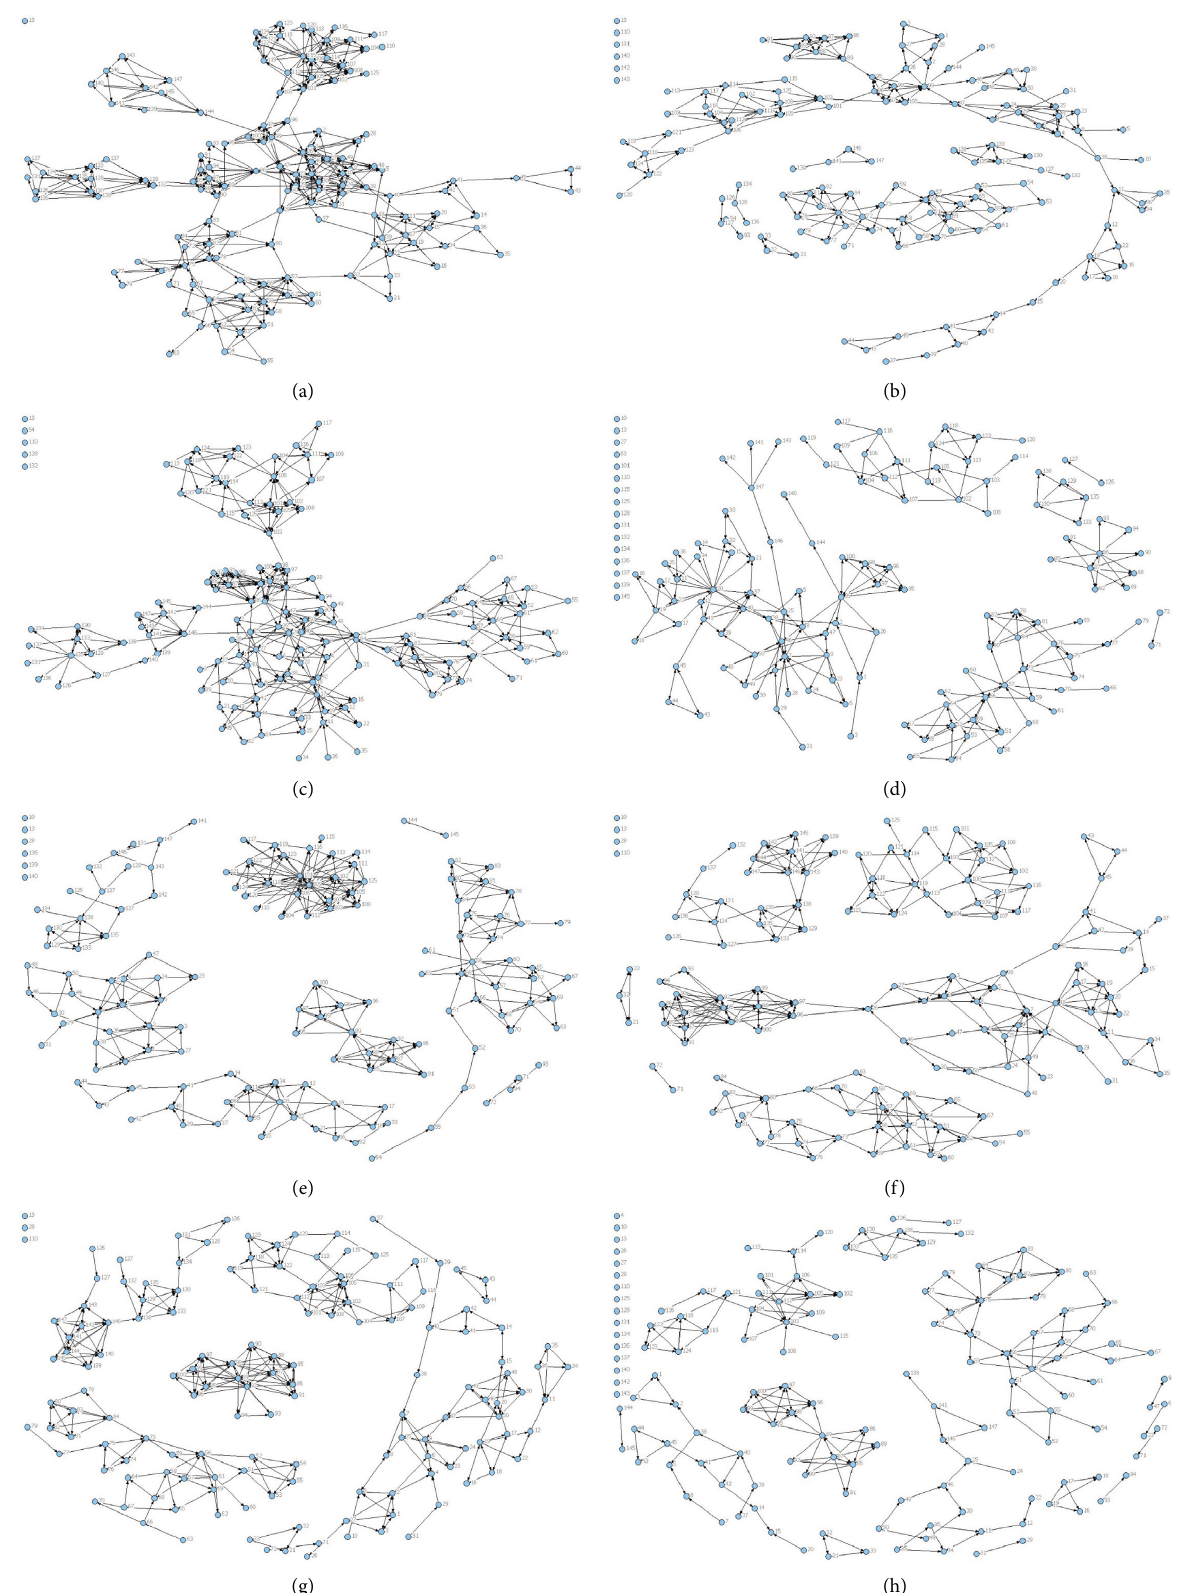
Figure 1: Topology diagrams of the overall social network of professional